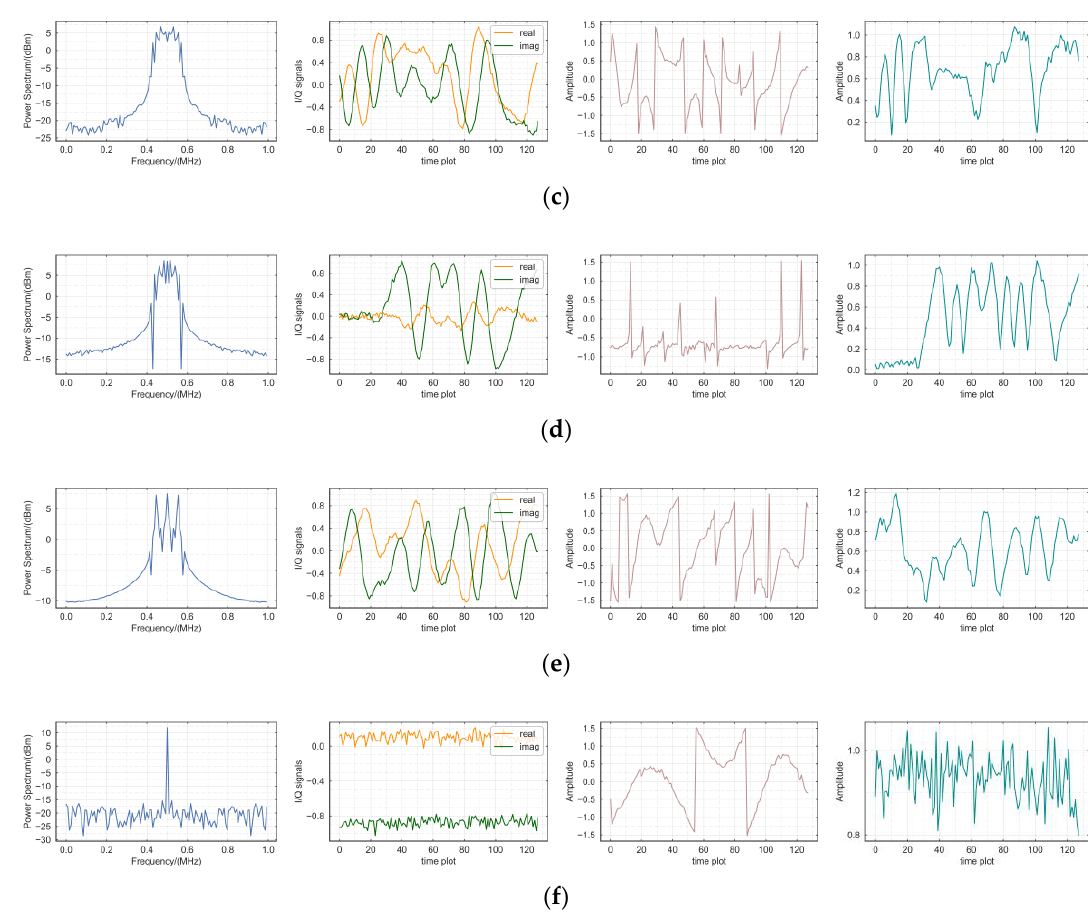
Figure 10. Power spectrum, I and Q, phase and amplitude signals time plot for various fake modulation signals: ( a ) 8PSK; ( b ) QPSK; ( c ) 16-QAM; ( d ) PAM4; ( e ) 64-QAM; ( f ) WBFM.